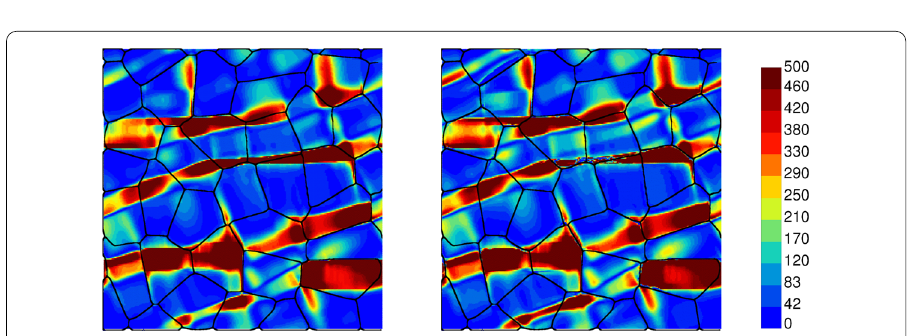
Fig. 10 The microstructure of the 32 grain geometry after holding the deformation constant for 1h. Top left: the orientation field, and top right: the phase-field φ , and bottom: the norm of the curvature |∇ θ | . There is only one possible slip-system